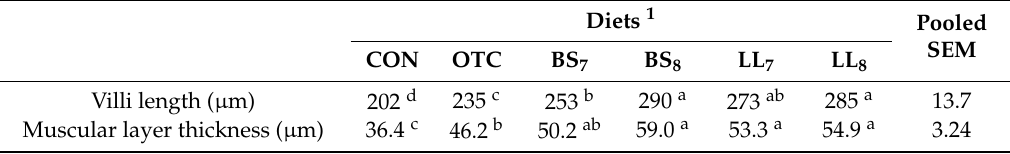
Table 7. Intestinal morphology of juvenile Nile tilapia fed the experimental diets for 8